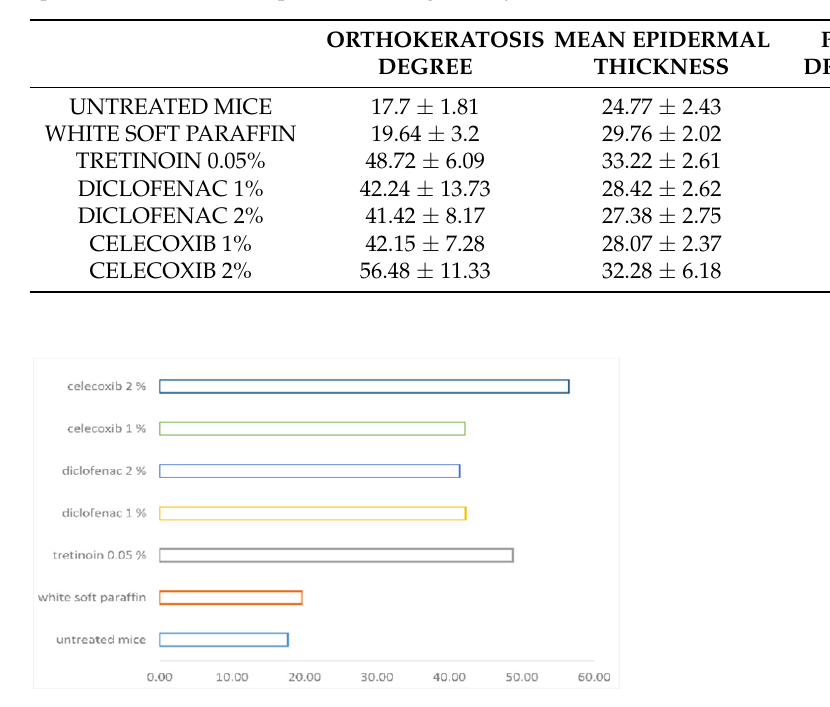
Table 1. The effect of tested substances expressed as orthokeratosis degree (as percent), mean epidermal thickness and percentual drug activity.